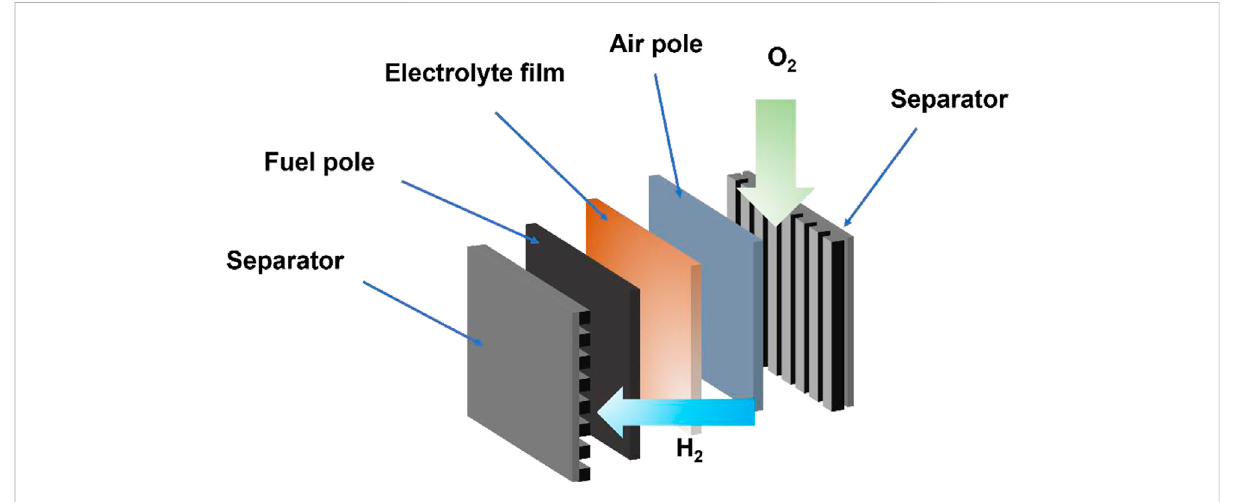
FIGURE 1 The con fi guration of a fuel